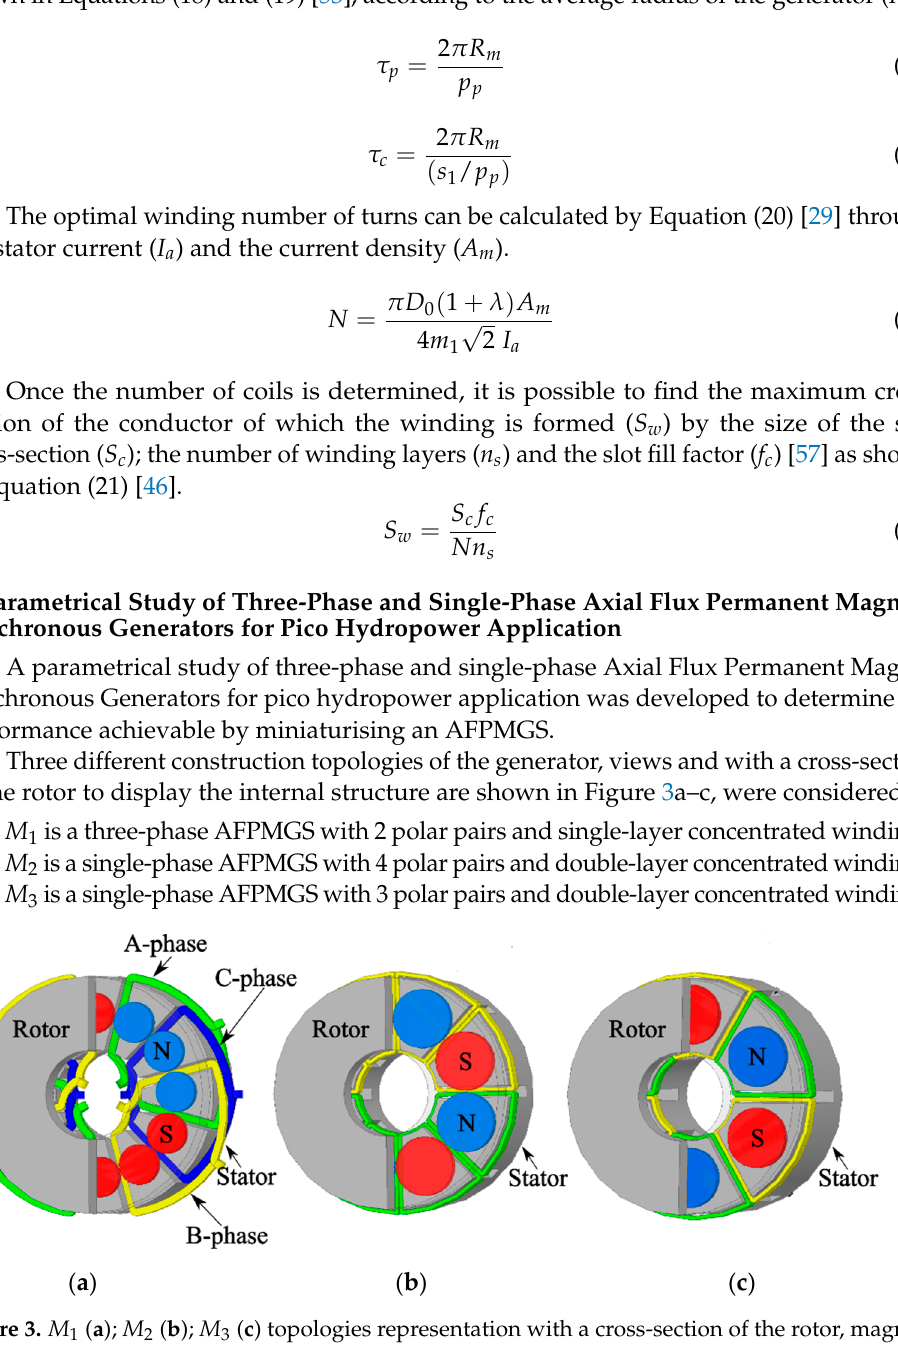
Figure 4. Winding layout of topologies M 1 ( a ), M 2 ( b ), M 3 ( c ). The windings of the M 1 three-phase topology were realised with phases A, B, C arranged with 120 degrees phase shift each other; while the single-phase M 2 and M 3